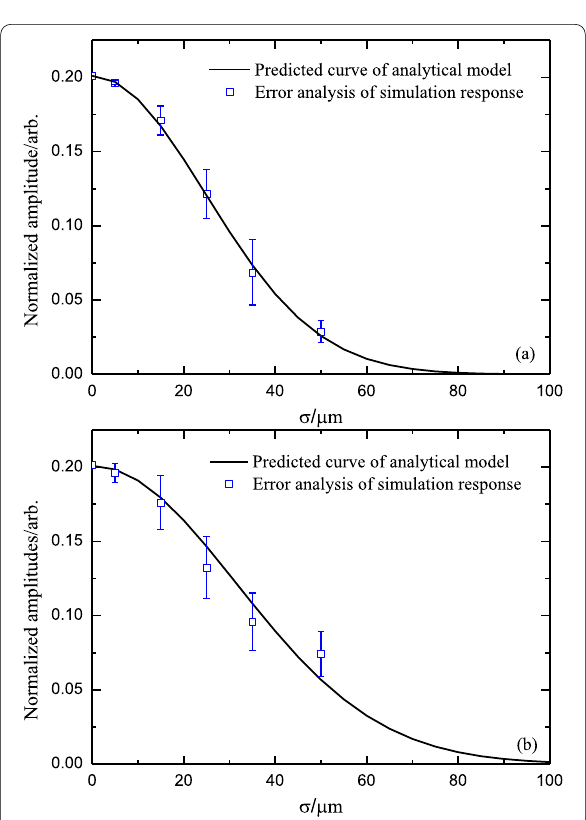
Figure 5 Comparison of simulation responses with predicted curve of analytical model under a rough front surfaces and b rough back